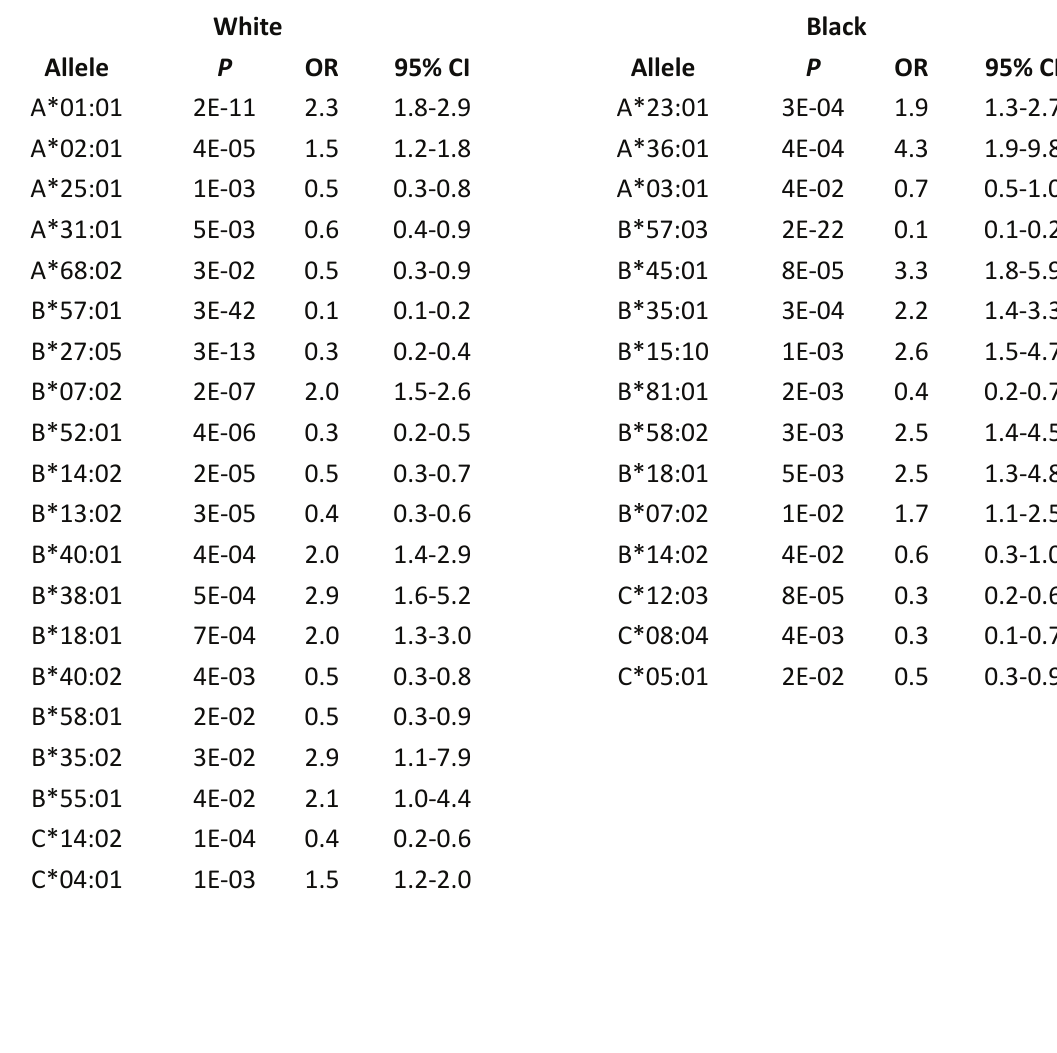
Supplementary Table 4. Effect of individual class I alleles on viral control (controllers vs non-controllers) based on a logistic regression model with stepwise selection including all HLA class I alleles with phenotypic frequencies of >2% (Table S5 in [